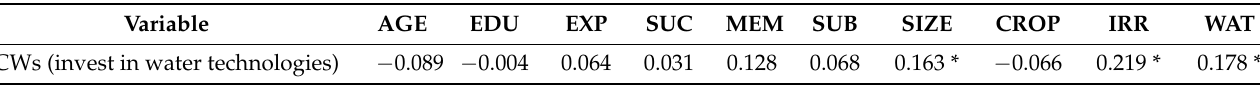
Table 11. Regression model between CWs investment and farmers’ sociodemographic characteristics. Variable AGE EDU WAT CWs (invest in water